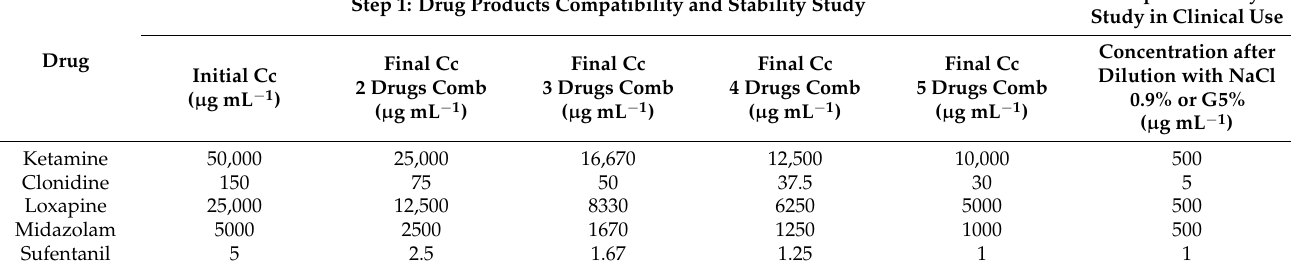
Table 3. Drugs mixtures quantitative